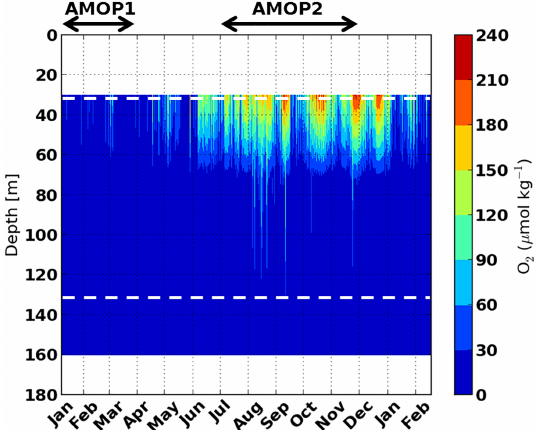
Figure 3. Time series in 2013 of the oxygen concentration (µmolkg − 1 ) covering the AMOP summer (denoted AMOP1) and AMOP winter–spring (denoted AMOP2) periods, acquired on the mooring location line through oxygen sensors at 34, 76, 147 and 160m of depth with a 15min acquisition frequency and vertically interpolated (see Fig. 1c and Sect. 2). The dashed horizontal white lines indicate the depth of the